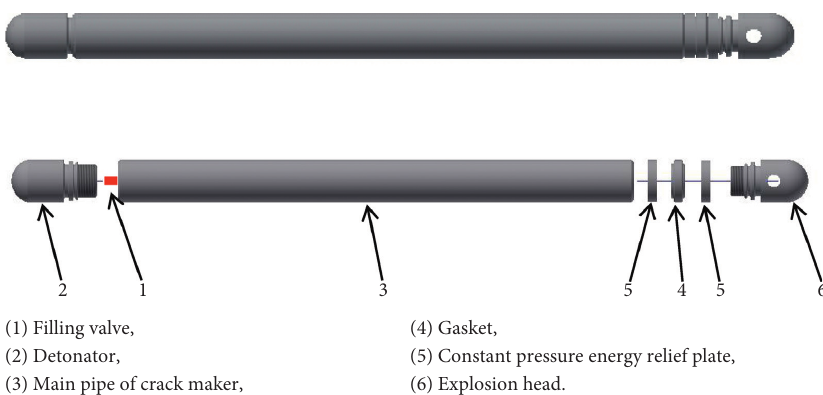
Figure 1: Schematic diagram of the liquid CO 2 crack generator. (1) Filling valve. (2) Detonator. (3) Main pipe of the crack maker. (4) Gasket. (5) Constant-pressure energy relief plate. (6) Explosion head.